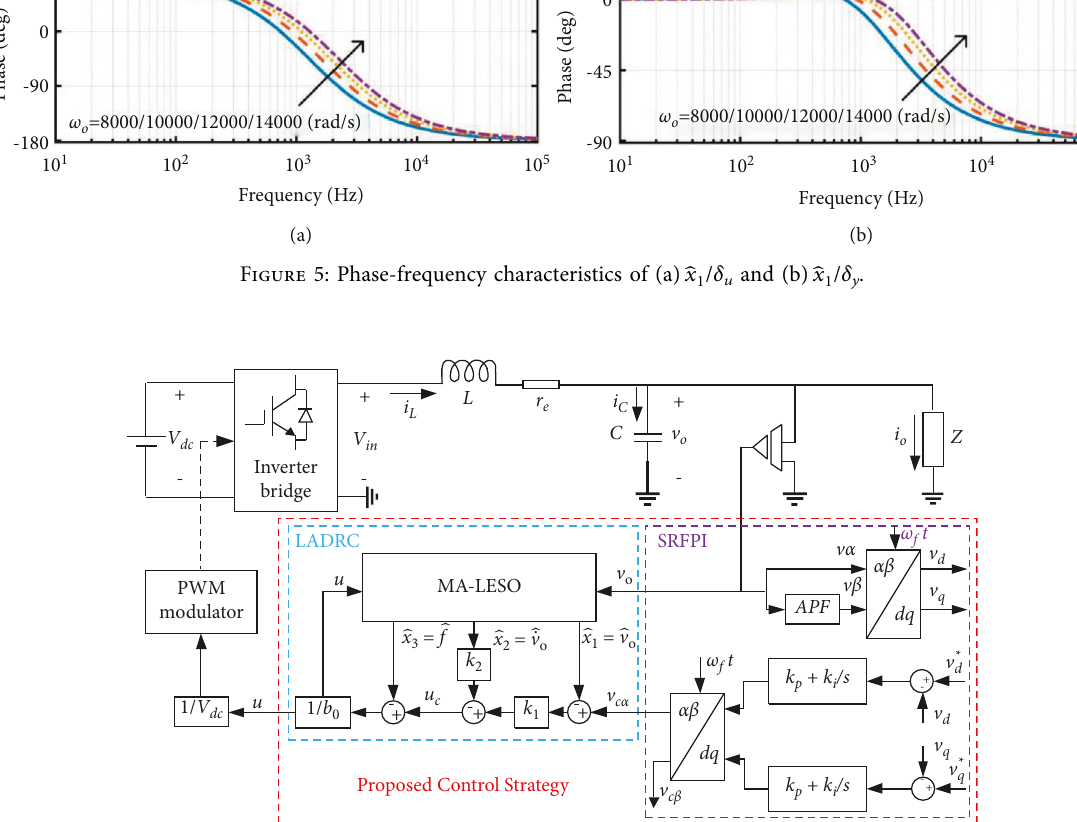
Figure 6: Proposed voltage control structure based on combined SRFPI and